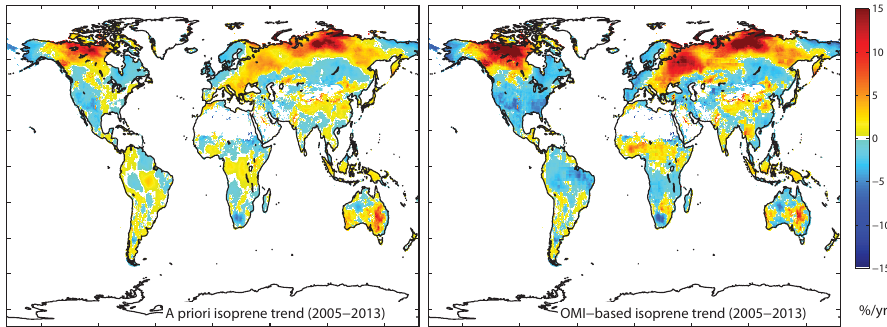
Figure 16. Global distribution of annual isoprene emission trends over 2005–2013 according to the a priori (left) and top–down inven- tory (right) expressed in percentage year − 1